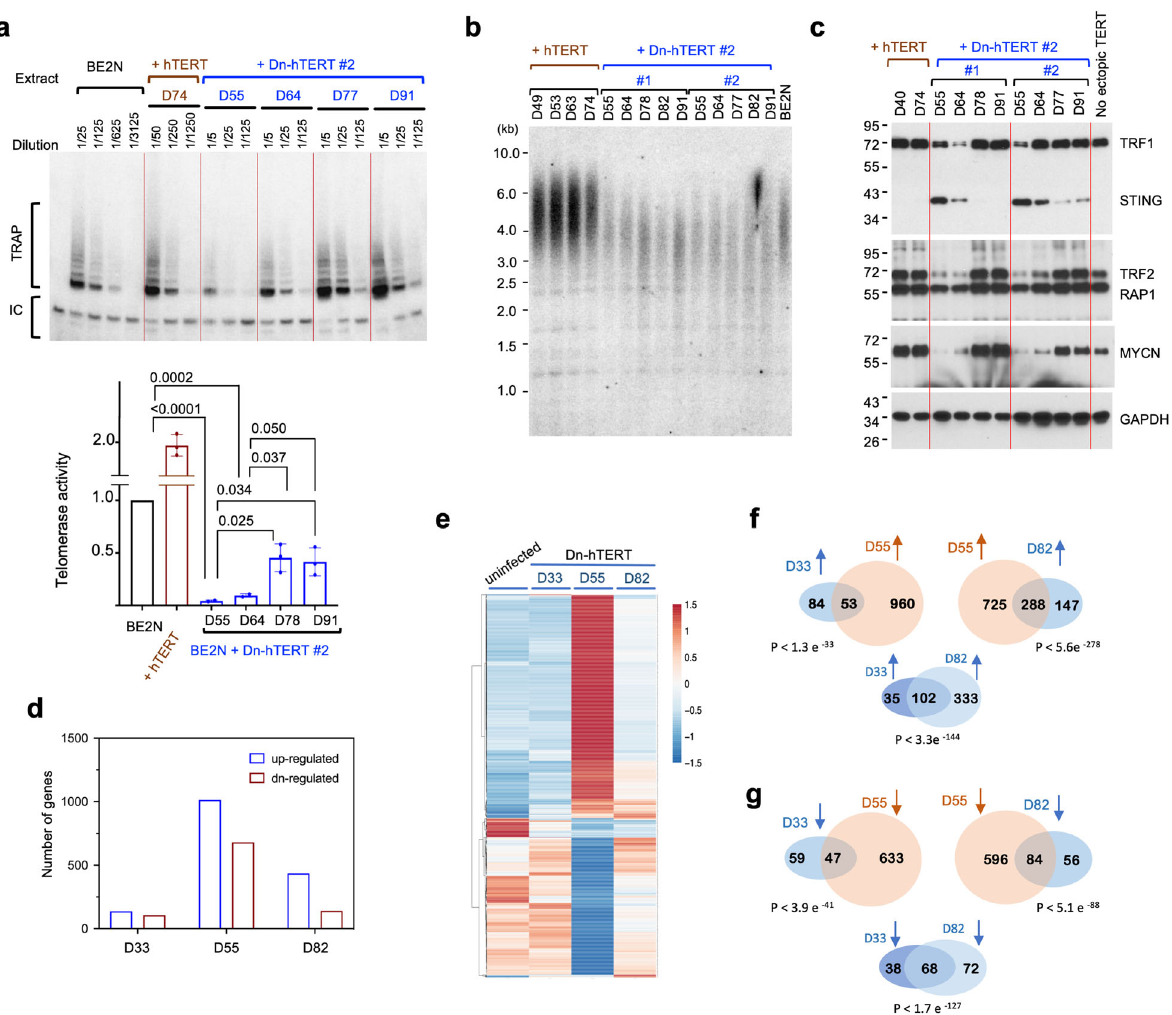
Fig. 4 Pro fi ling of BE(2)N cells during Dn-hTERT-induced switch from ADRN to MES cell types. a TRAP analysis of telomerase activity in BE(2)N harboring either hTERT or Dn-hTERT at different time points following retrovirus infection. The assays were performed using serial dilutions of the extracts as indicated. The relative activity of each extract was quanti fi ed using ImageQuant and plotted at the bottom (mean ± S.D., n = 2 or 3 experimental replicates). Pair-wise P -values were determined using student ’ s t -tests (two-tailed). b Analysis of telomere length distributions in BE(2)N harboring either hTERT or Dn-hTERT at different time points following retrovirus infection. c Western analysis of telomere and lineage-related proteins in BE(2)N during passage of cells infected with viruses that harbor either hTERT or Dn-hTERT. d The number of upregulated and downregulated genes in Dn-hTERT-treated BE(2)N at the indicated time points (by >2-fold in comparison to the DMSO-treated control cells) were determined from RNA-seq analysis and plotted. e The expression patterns of the ~1000 genes that show the greatest changes in mRNA levels (>2 fold) in BrdU-treated BE(2)N were displayed using Heatmap. f Pair-wise comparison of the degrees of overlaps between genes upregulated by Dn – hTERT treatment at different time points. g Pair – wise comparison of the degrees of overlaps between genes downregulated by Dn-hTERT treatment at different time